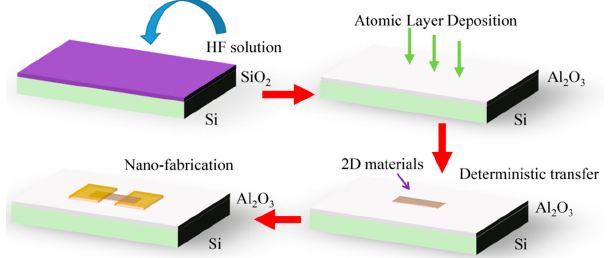
Figure 1. The process of fabricating graphene (or WS 2 ) field effect transistors (FETs) on Al 2 O 3 /Si substrates. HF: hydrofluoric acid. substrates. HF: hydrofluoric